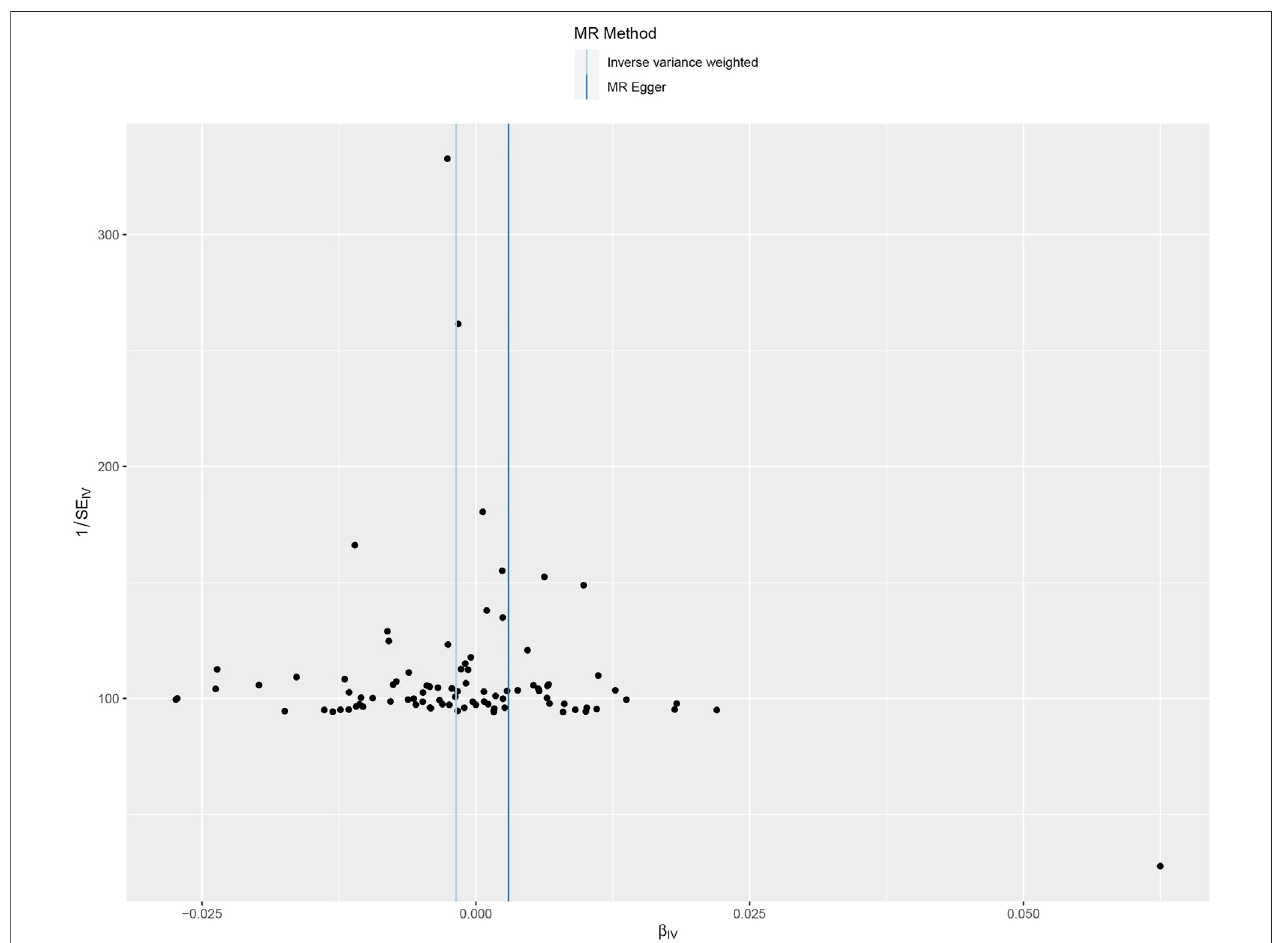
FIGURE 4 | Funnel plot to visualize overall heterogeneity of Mendelian randomization assessment for the effect of tea consumption on obesity. MR, Mendelian randomization; SE, standard error; IV, instrument variable.